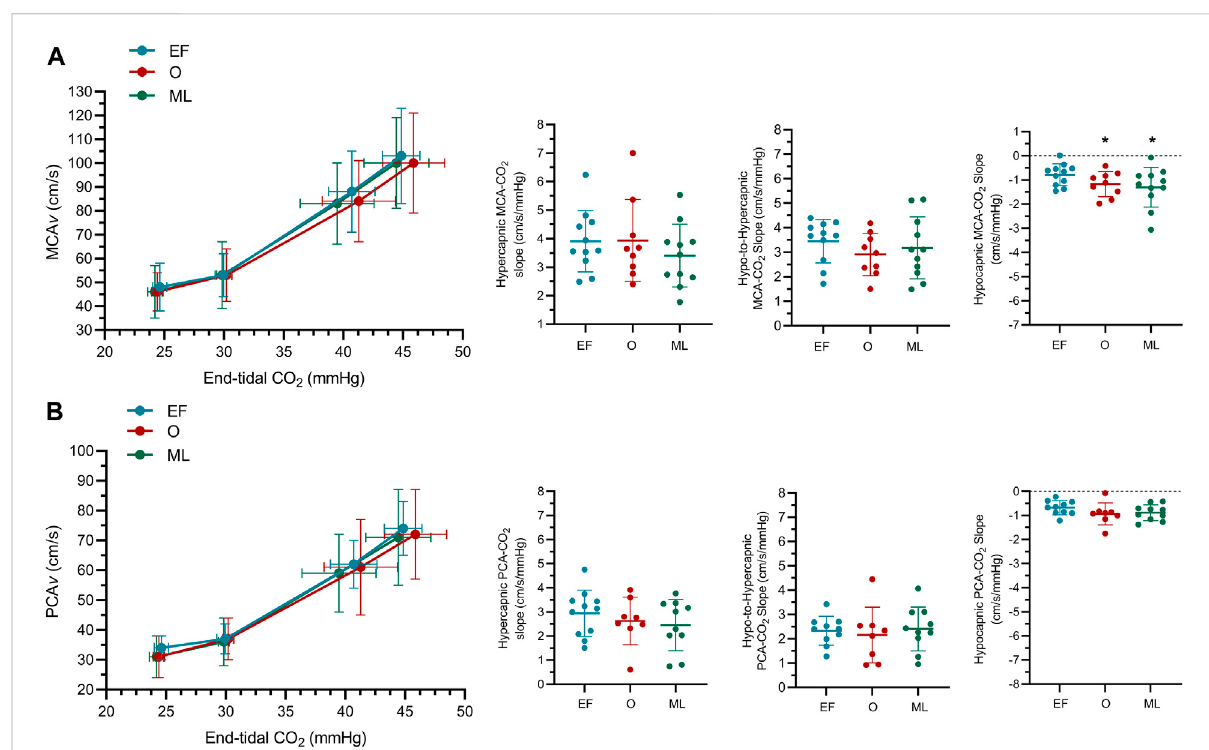
FIGURE 2 The middle (A) and posterior (B) cerebral blood velocity (MCA v ; PCA v ) slope at hyper-, hypo-to-hyper- and hypocapnia (MCA v -CO 2 responsiveness, PCA v